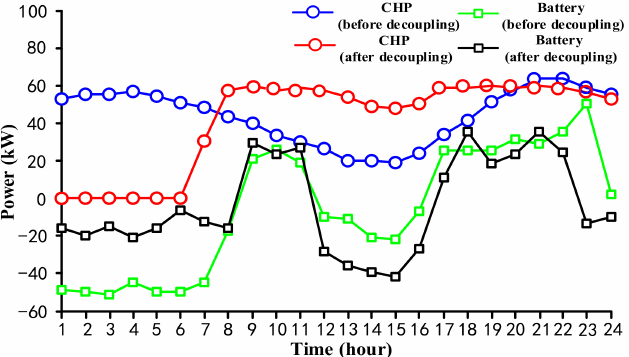
Figure 7. Simulation results of the output power of the battery and